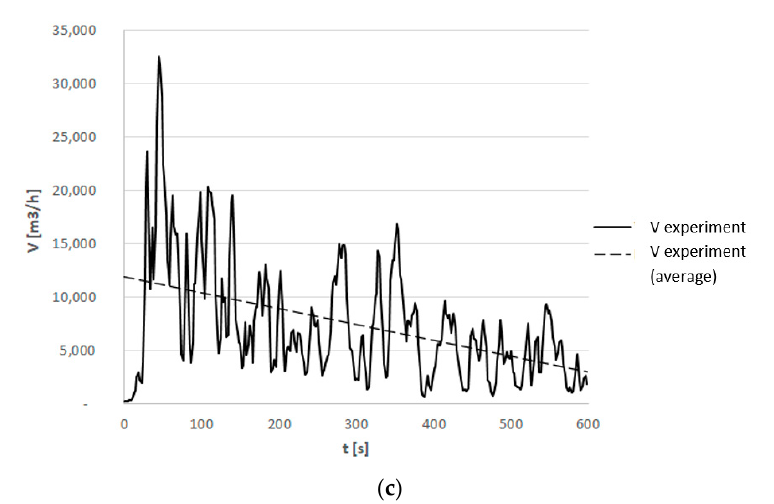
Figure 9. The air volume flowing through the smoke damper based on measurements for several values of outdoor temperature ( a ) − 2.0 °C, ( b ) 15.6 °C, and ( c ) 35.4 °C.